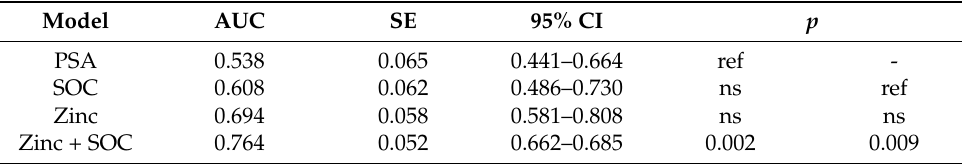
Table 10. Diagnostic performance in repeated